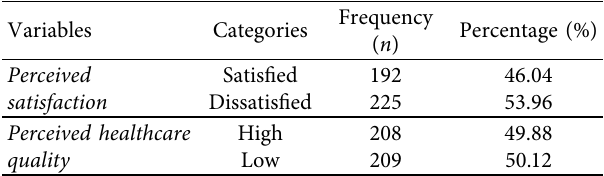
Table 1: Respondents’ sociodemographic characteristics ( n � 417). Variables categories